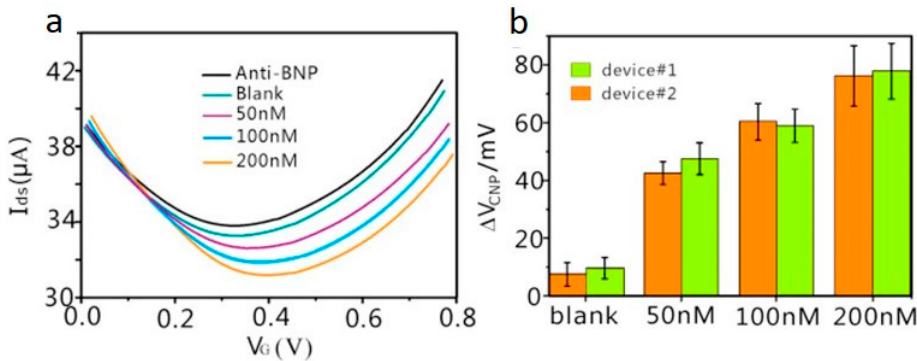
Figure 9. ( a ) Transfer curves of a PtNPs-decorated rGO-FET in response to brain natriuretic peptide (BNP) in whole blood samples which have been treated with a microfilter; ( b ) Dirac voltage shift in response to the differing concentrations of BNP. Adapted from [46], Copyright 2017, with permission from Elsevier.